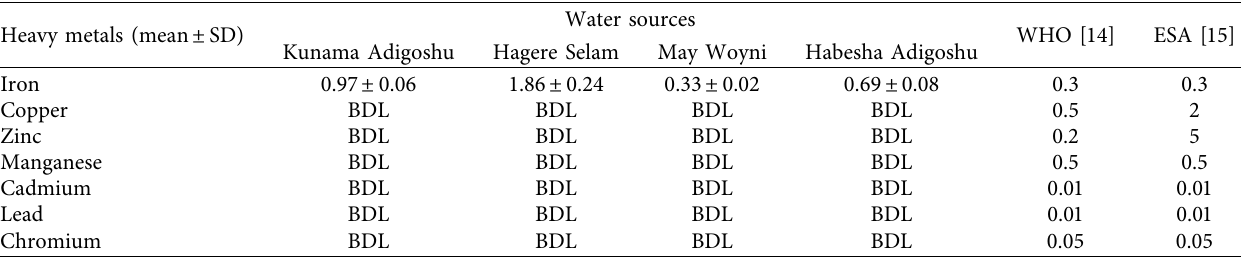
Table 2: The heavy metal concentrations (mean ± SD, N � 3, mg/L) of hand-dug well water sources of Kafta Humera